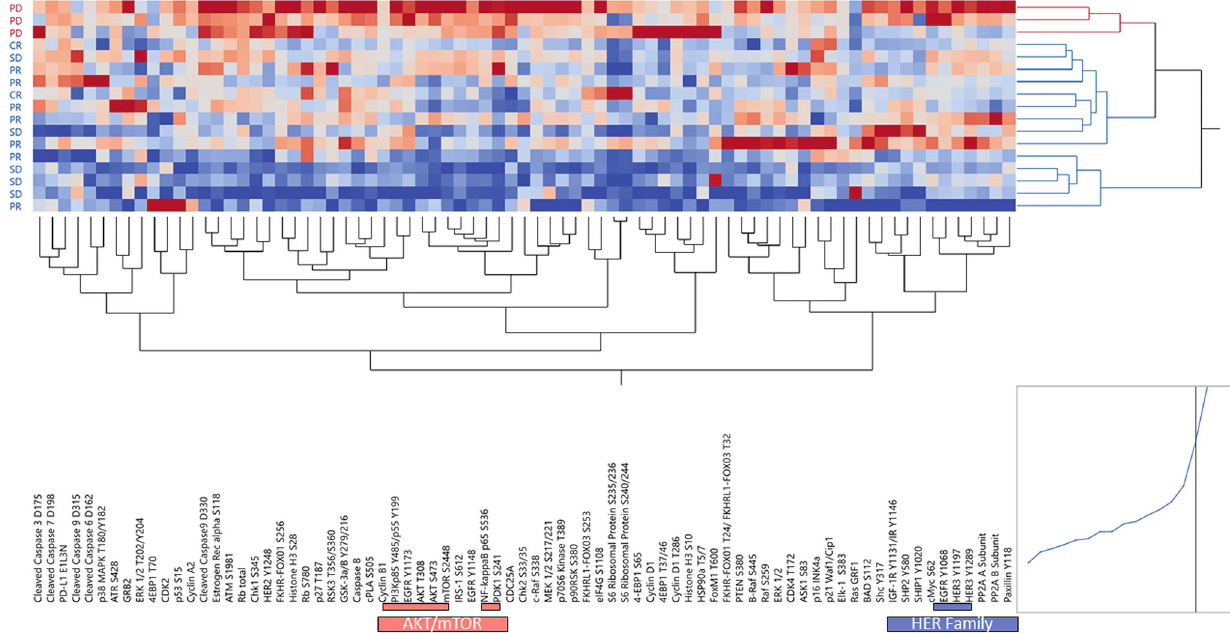
Fig. 5 Expression and activation levels of qualifying and exploratory biomarkers in the stroma of responders and non-responders. Unsupervised hierarchical clustering analysis using Ward ’ s method displays kinases and their substrates in the microdissected stroma surrounding the tumor cells collected from 17 of the 20 evaluable patients. RPPA relative intensity values are displayed on a scale ranging from red to blue, where red indicates high levels and blue indicates low levels of expression/activation. On the x-axis are listed proteins measured by RPPA; on the y-axis patients ’ outcomes are displayed; samples were color-coded based on response rates where blue indicates responders (CR, PR, and SD) and red non-responders (PD). Members of the PI3K/AKT/mTOR signaling pathway and HER family co-clustering together are highlighted on the x-axis in red and blue,